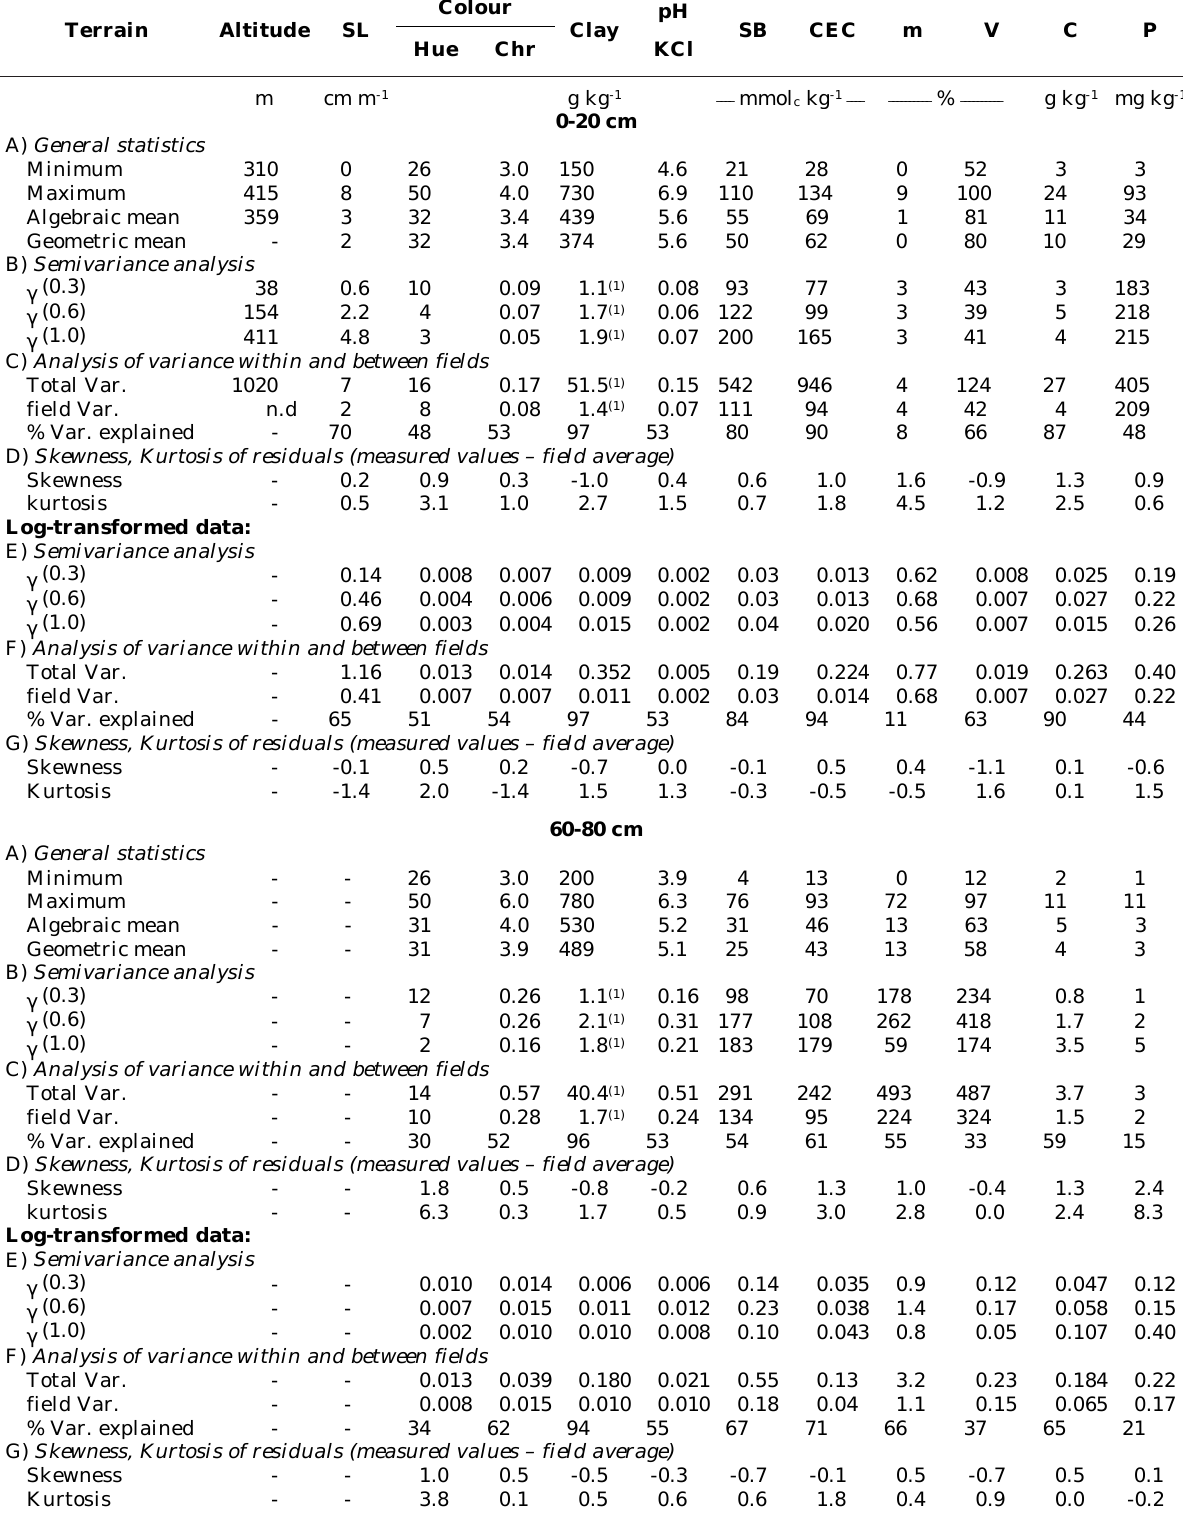
Table 3. Summary of statistical analysis of soil characteristics of soybean fields in the Assis region (seven fields, 62 sites)